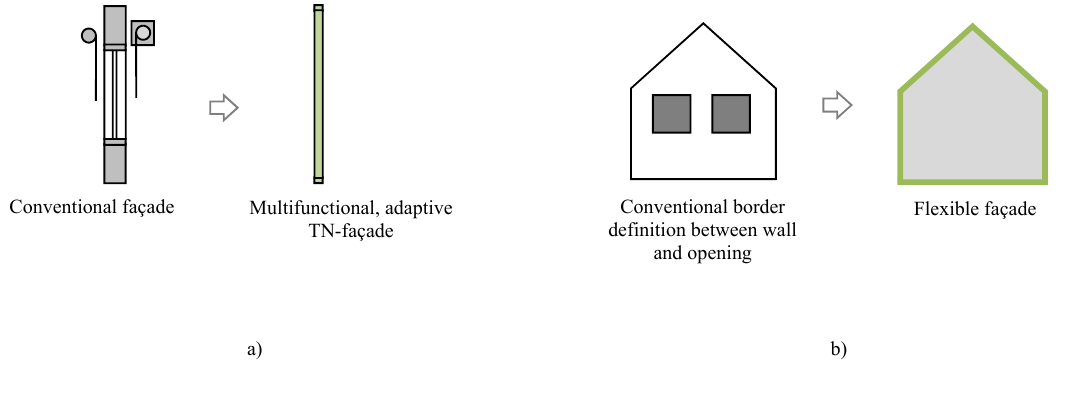
Fig. 9 Evolution aspects of the building façade. Drawings: M. Husser,